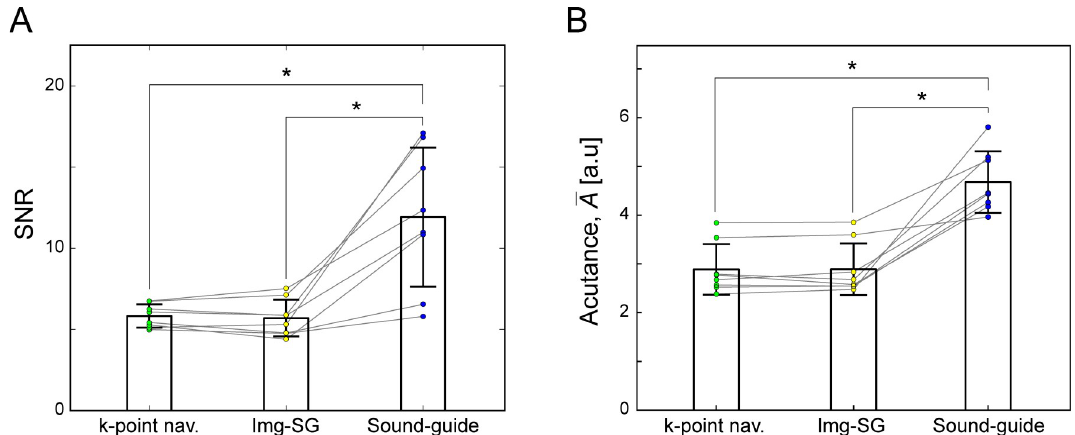
Fig 7. Quantification of blood inflow effects. A) Signal-to-noise ratio (SNR) of the lung tissues was significantly higher with Sound- guide than with k-point navigator ( p = 0.0038) and Img-SG ( p = 0.0027), but the difference between k-point navigator and Img-SG was not significant ( p = 0.52). A cubic ROI selected in the right lung is shown in the k-point navigator image in Fig 5A with a yellow box. B) An average of acutance, � A � , was calculated for the identical ROI to SNR calculation. The � A � values were significantly larger for sound-guided respiration than for k-point navigator ( p = 0.0007) and Img-SG ( p = 0.0006). The difference between k-point navigator and Img-SG was not significant ( p = 0.94). Colored points represent the values for individual subjects ( N = 8). � represents p < 0.05/ 3 = 0.017 with Bonferroni adjustment for multiple comparison.